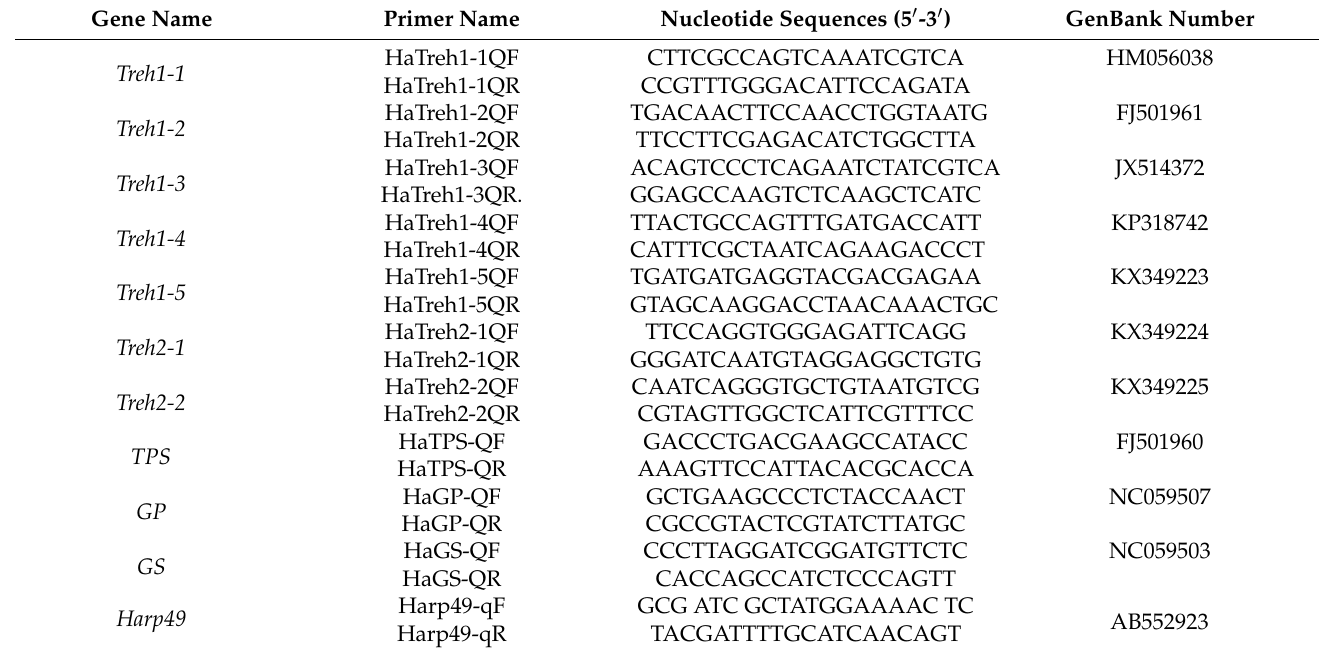
Table 1. Primers used in real-time polymerase chain reaction.